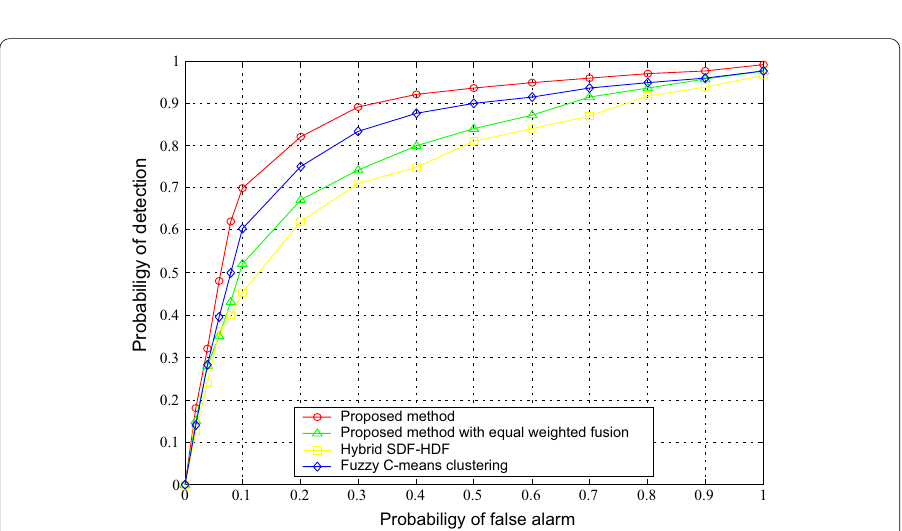
Fig. 2 Comparison of detection probability under different probability of false alarm ( N